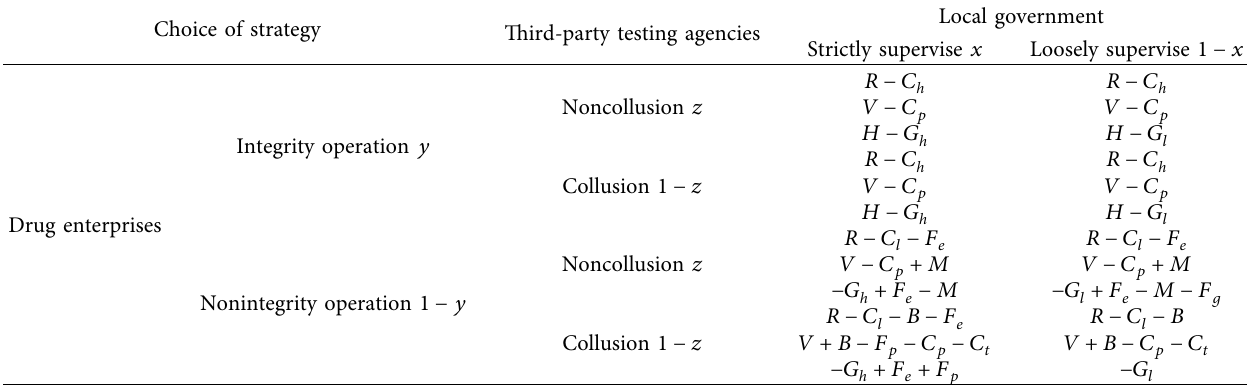
Table 2: Three-party mixed strategy game